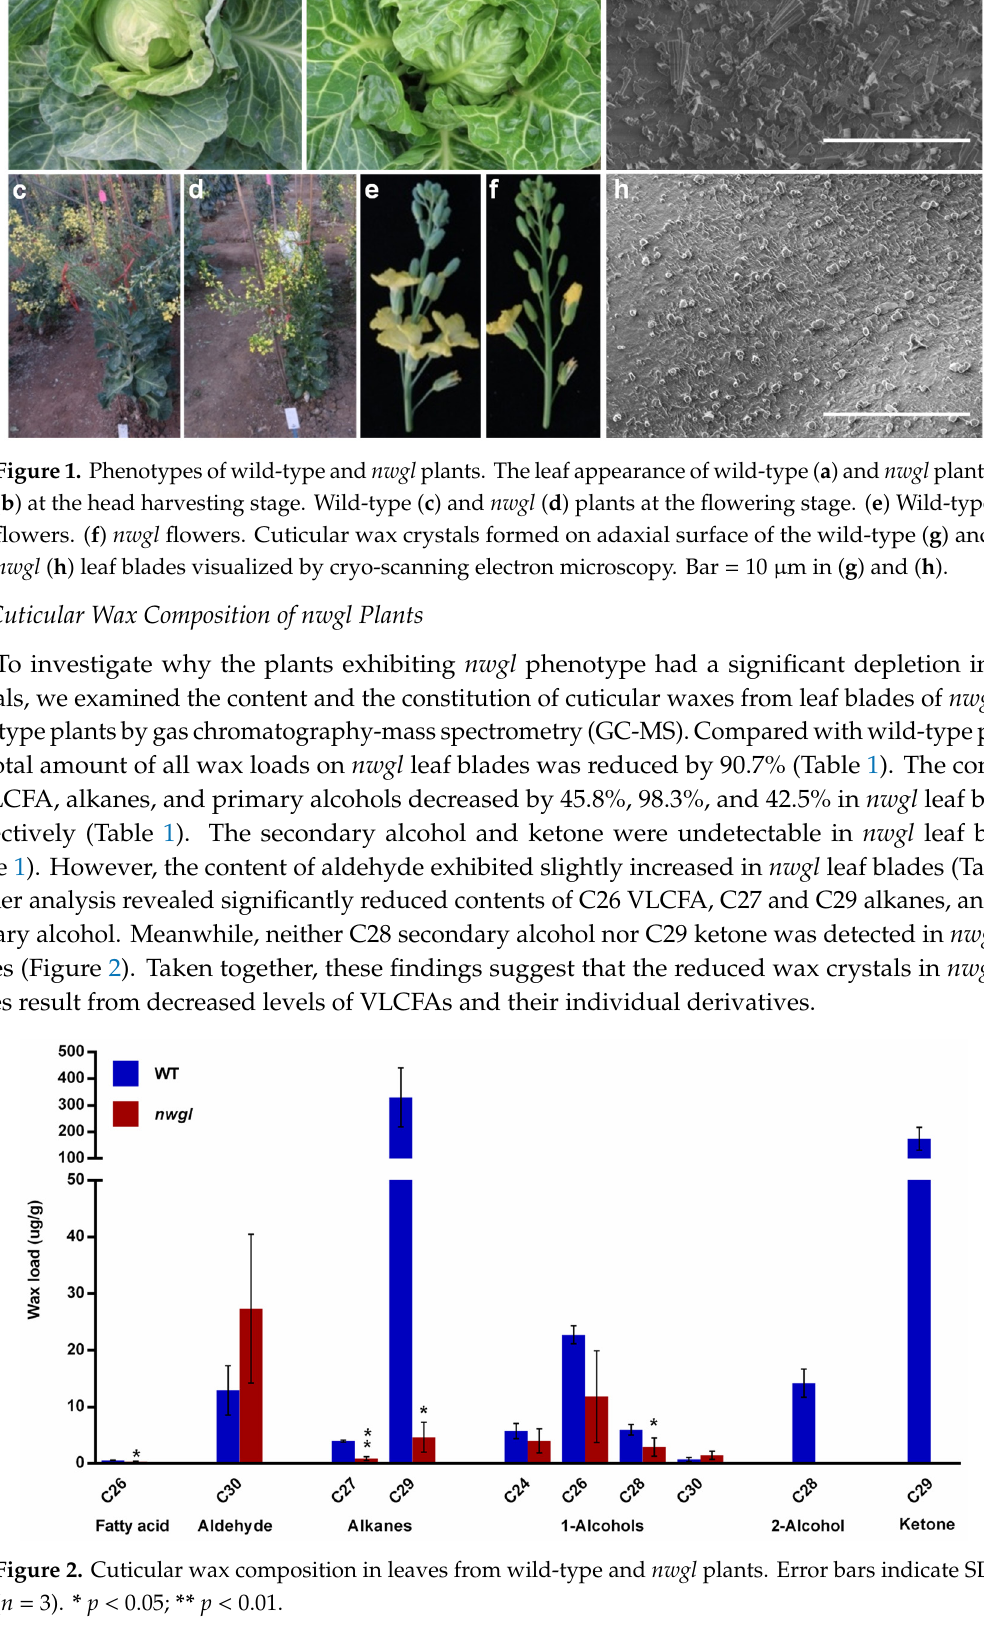
Figure 2. Cuticular wax composition in leaves from wild-type and nwgl plants. Error bars indicate SD ( n = 3). * p < 0.05; ** p < 0.01.